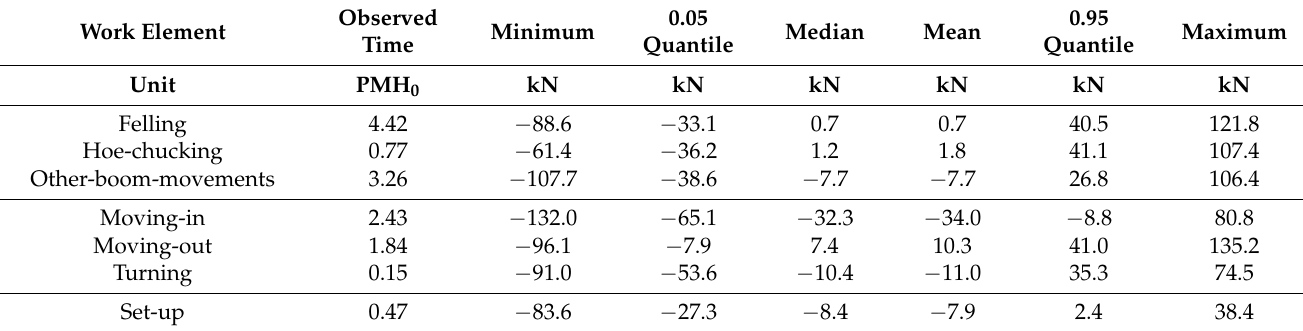
Table 3. Local differences in cable tensile forces between the harvesting and anchor machine. Work